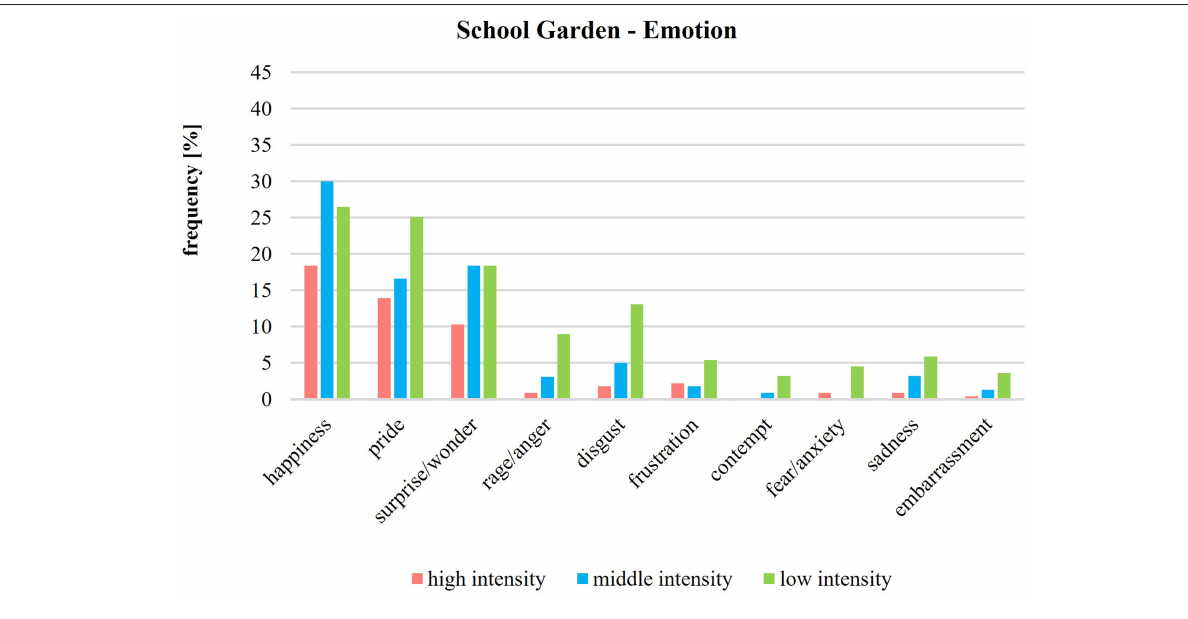
FIGURE 4 | Intensity of emotions during school garden lessons ( n =